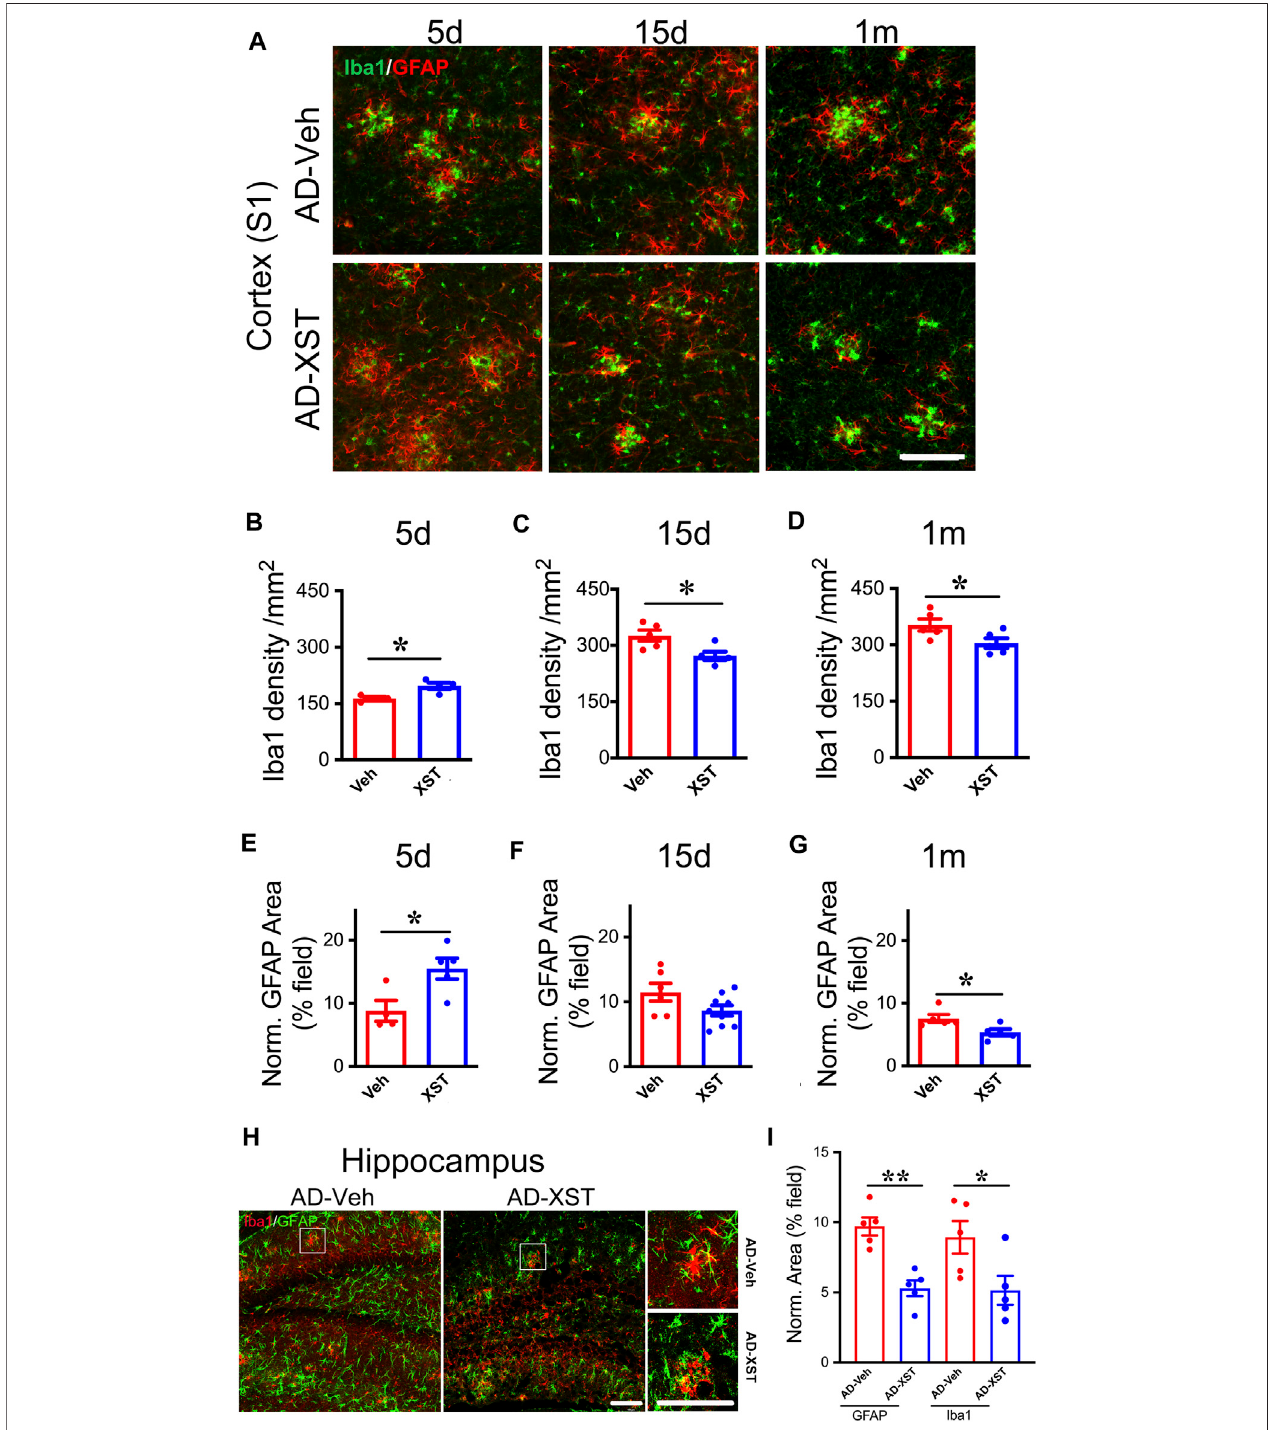
FIGURE5| TimecourseofXST ’ simpact onmicrogliaandastrocytesinAPP/PS1mice. (A) Sampleimagesofmicroglia(Iba1, green)and astrocytes(GFAP,red)in the cortex (S1)ofAPP/PS1 mice after treatment withXST for5 days, 15 days, or1 month.Scale bar,100 μ m. (B – D) Quanti fi cation ofIba1 + density after 5 days (B) ( p (cid:2) 0.0112, t -test, n (cid:2) 4micepergroup),15 days (C) ( p (cid:2) 0.0233, t -test,AD-Veh, n (cid:2) 5mice,AD-XST, n (cid:2) 4mice),and1 month (D) ( p (cid:2) 0.0487, n (cid:2) 5micepergroup)ofXST treatment in APP/PS1 mice. (E – G) Quanti fi cation of GFAP + area after 5 days (E) ( p (cid:2) 0.0253, t -test, AD-Veh, n (cid:2) 4 mice, AD-XST, n (cid:2) 5 mice), 15 days (F) ( p (cid:2) 0.0798, t -test, AD-Veh, n (cid:2) 6mice,AD-XST, n (cid:2) 9mice), and 1 month (G) ( p (cid:2) 0.0291, t -test, n (cid:2) 5per group) ofXSTtreatmentinAPP/PS1mice. (H) Sampleimagesof microglia (Iba1, red) and astrocytes (GFAP, green) in the hippocampus of APP/PS1 mice after treatment with XST for 15 days. Scale bar, 100 μ m. (I) Quanti fi cation of GFAP + area ( p (cid:2) 0.009, t -test, n (cid:2) 5 mice per group) and Iba1 + area ( p (cid:2) 0.04, t -test, n (cid:2) 5 mice per group) in APP/PS1 mice after treatment with XST for 15 days. Data are mean ± SEM. * p < 0.05; ** p < 0.01.